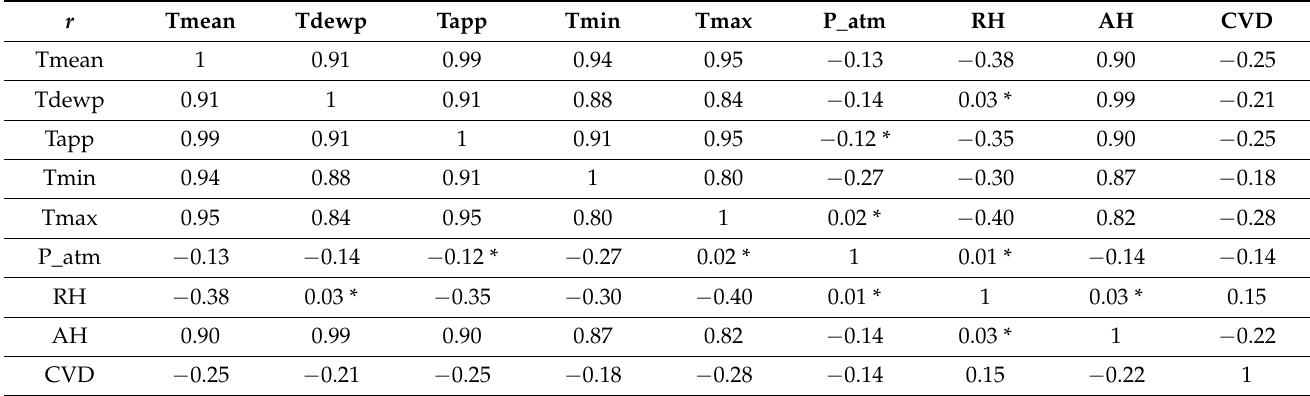
Table 7. Correlation matrix; the asterisks indicate the cases in which the hypothesis null on p -value is not satisfied.